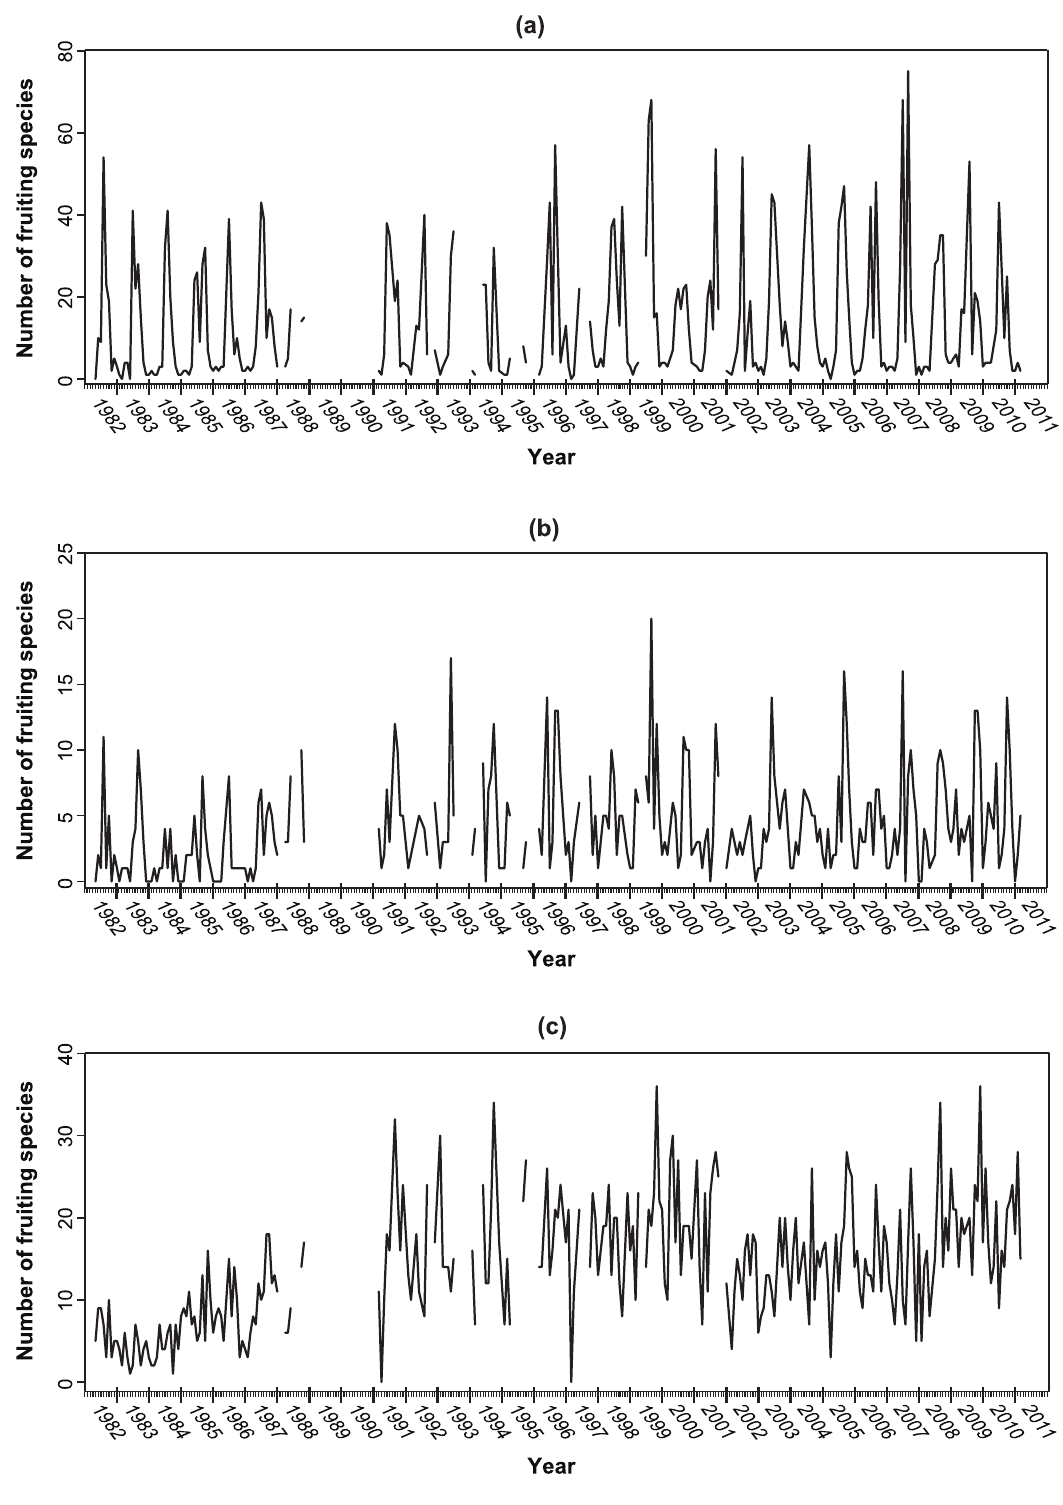
Figure 1. Counts of mushroom fruiting species throughout the survey years for ectomycorrhizal fungi (a), litter-decomposing fungi (b), and wood-decomposing fungi (c).